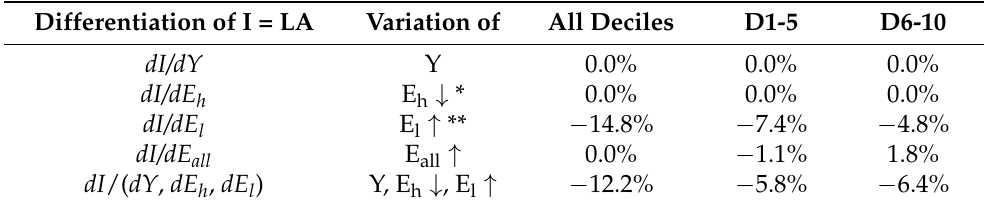
Table 4. Results of sensitivity scenarios for “low absolute expenditures” (10% change of indicator components).